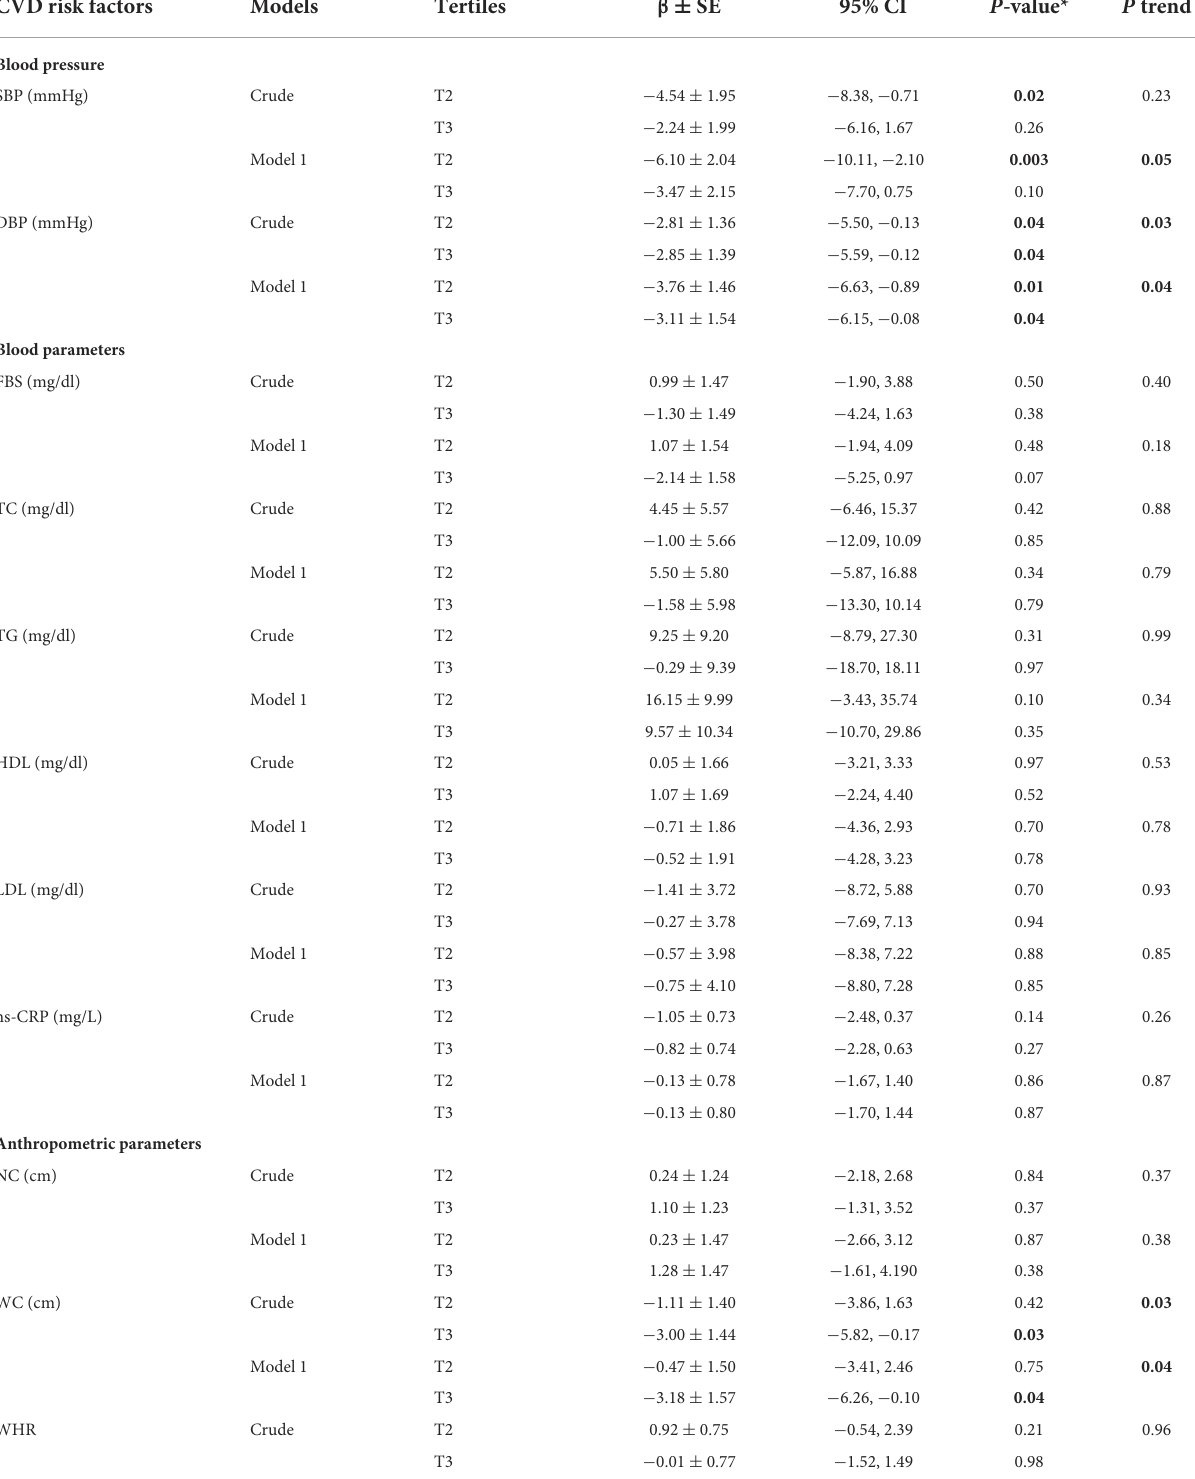
TABLE 5 The association between CQI with CVD risk factors, anthropometric measures, and body composition of study participants ( n = 291). CVD risk